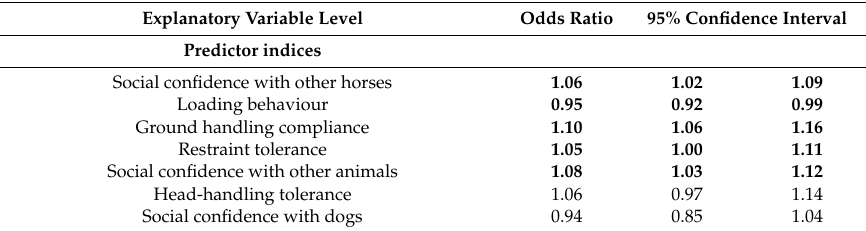
Table 5. Ordinal logistic regression results: Predictor variables, including the seven created predictor indices (rotated components), found to be associated with safety-from-rear in owner-reported horses (n = 1584). Significant values displayed in bold with Odds Ratio (OR) > 1 indicating increased safety-from-rear and OR < 1 indicating decreased safety-from-rear.